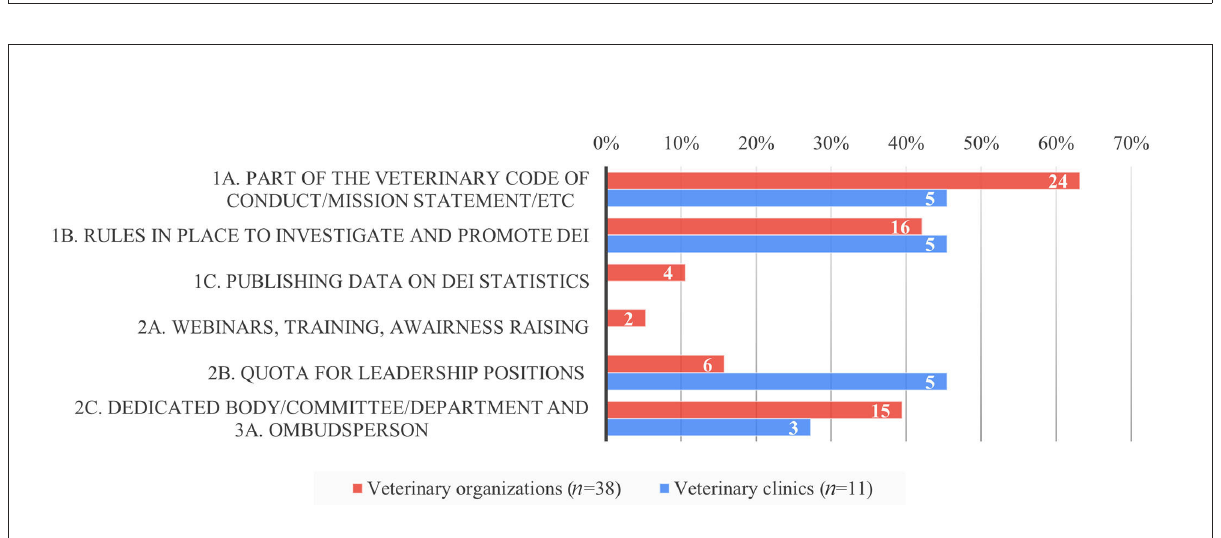
FIGURE5 Relative proportion of DEI strategies implemented per tier and respondent group in per cent ( y -axis) and absolute numbers (inside the bars) based on the survey responses.